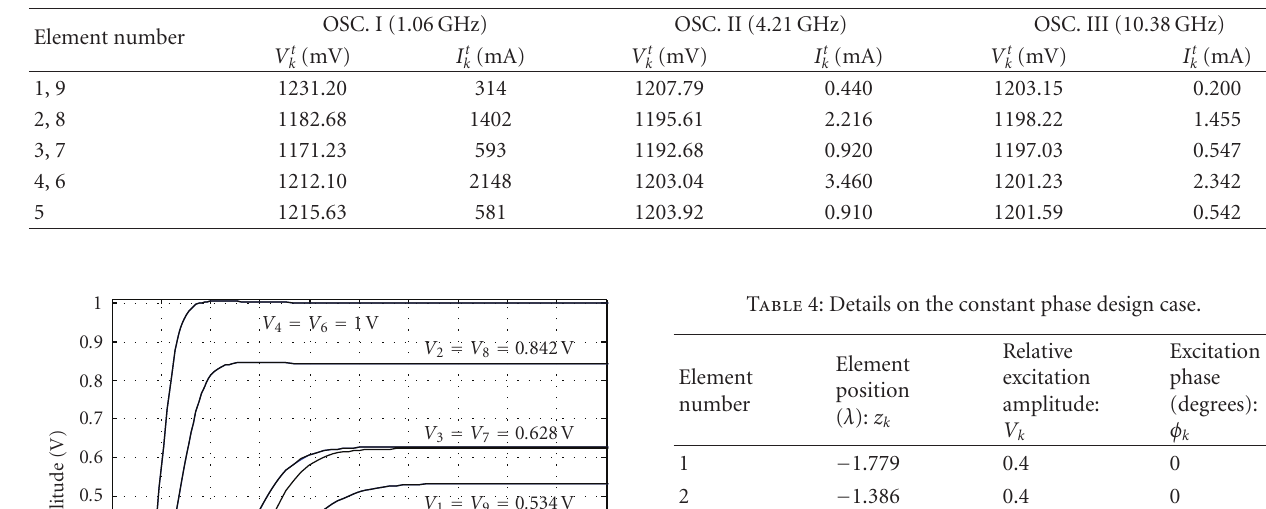
Table 3: The tuning parameters for the general design case.